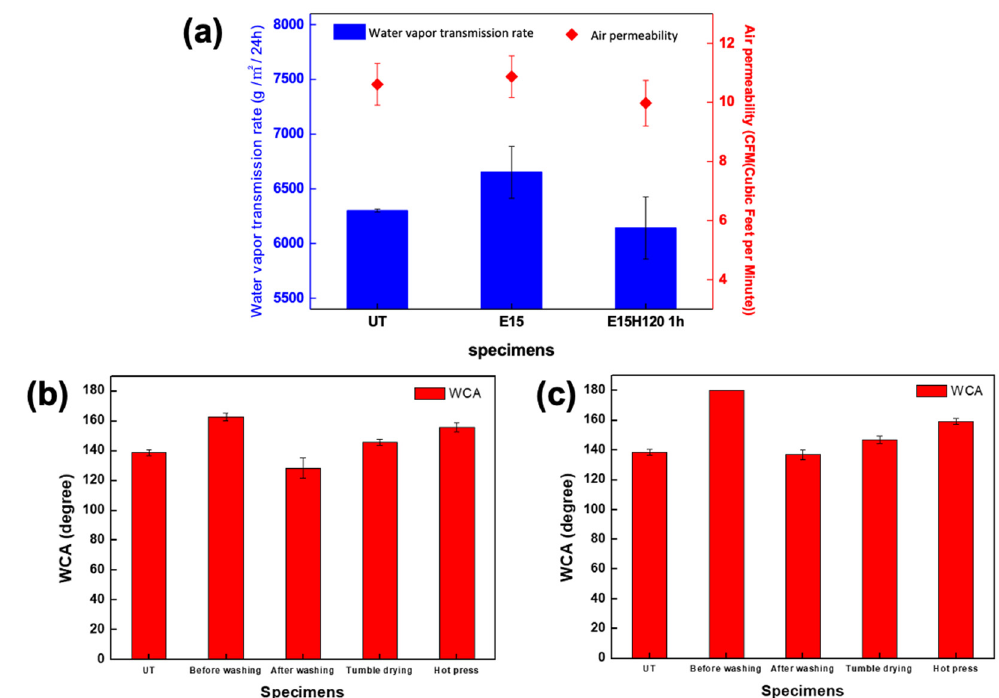
Figure 6. Water vapor transmission rate and air permeability of untreated PP fabric (UT), PP fabric treated with plasma etching for 15 min (E15), and PP fabric treated with plasma etching for 15 min and thermal aging at 120 °C for 1 h (E15H120 1 h) ( a ). Static contact angles before and after washing,